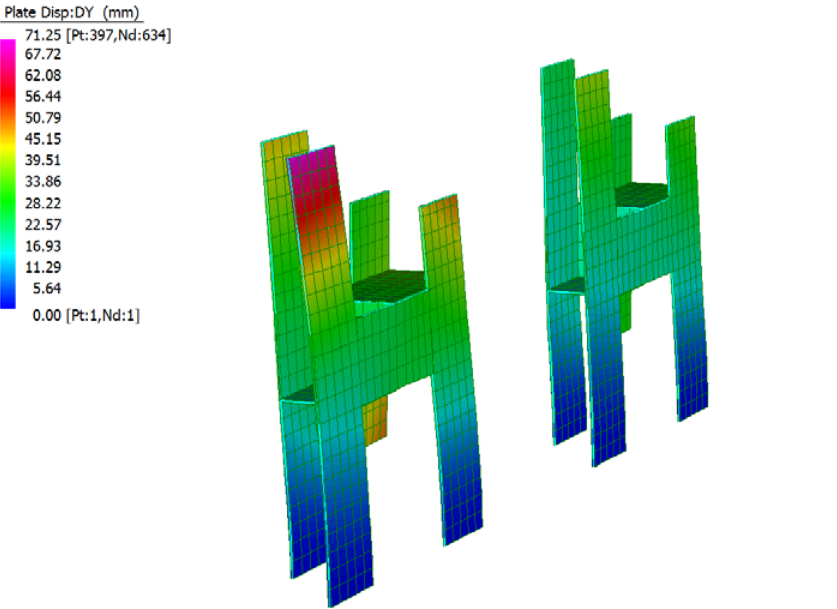
Fig. 4: Displacements: Left structure with zero gap elements / right structure with monolithic linked glass